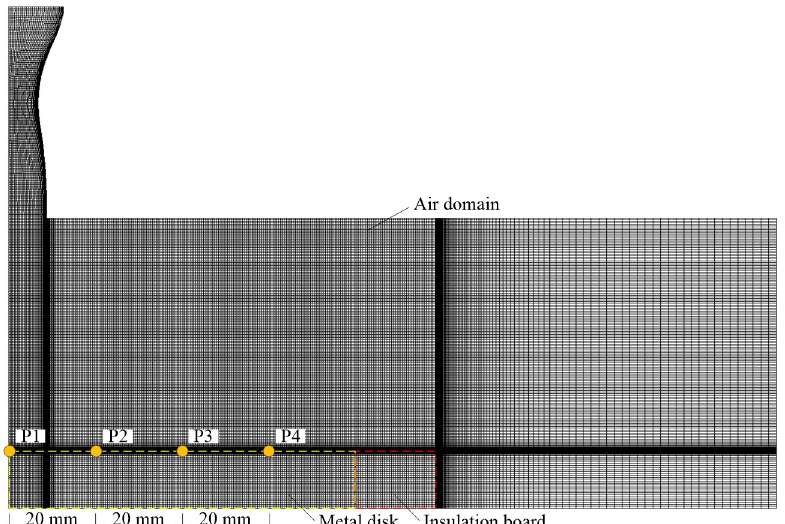
Fig 6. Mesh arrangement of fluid and solid domains of the forced air